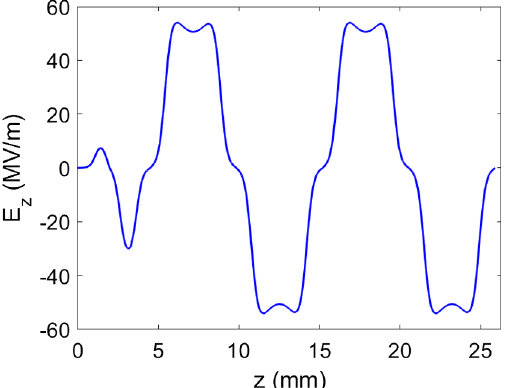
FIG. 7. Optimized field profile from the 1D tracking code optimization.